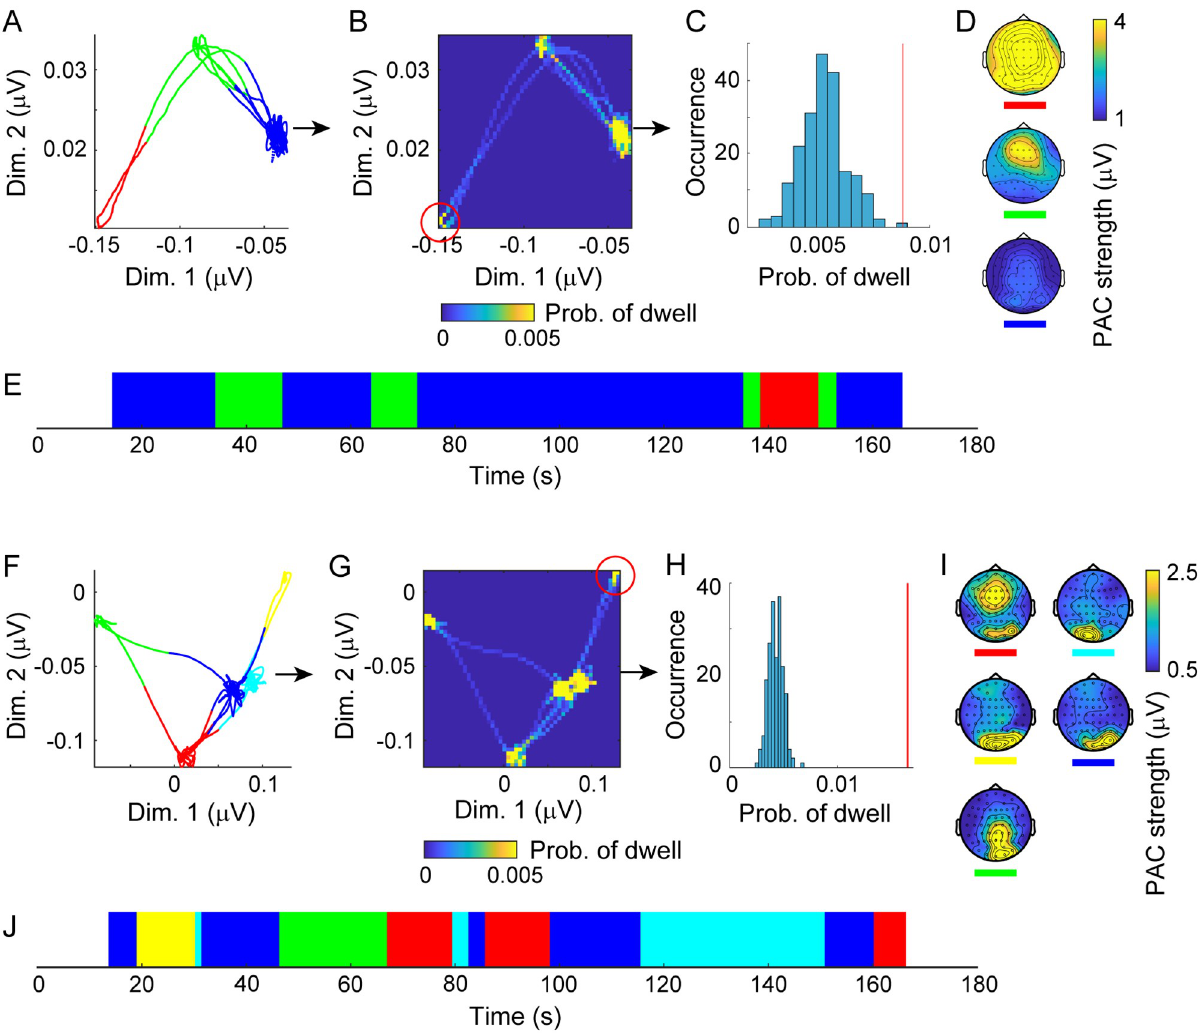
Fig 4. Transition dynamics among delta-alpha PAC states in a lower-dimensional space. (A to E) Representative delta-alpha PAC dynamics for an individual with higher attention-related AQ subscores (refer to Fig 3A to 3D(i)). (F to J) Representative dynamics for an individual with lower scores (refer to Fig 3D(ii)). (A, F) The trajectory of labeled signals in a plane. (B, G) The corresponding bivariate histograms. (C, H) Surrogate data testing under a condition of d = 2. (D, I) The resulting delta-alpha PAC states (represented by the mean PAC strengths). (E, J) Transitions between the identified PAC states. Surrogate data testing was applied to the density of points indicated by the red circles in panels B and G and the red lines in panels C and H, and the null hypothesis H 0 in condition d = 2 was rejected (C and H). The delta-alpha PAC dynamics tended to stay in a state for a longer time and to visit a lower number of states in individuals with higher AQ subscores for attention to detail and attention switching (compare E with J). The colors in panels A, E, F, and J indicate distinct states, as depicted in D and I.